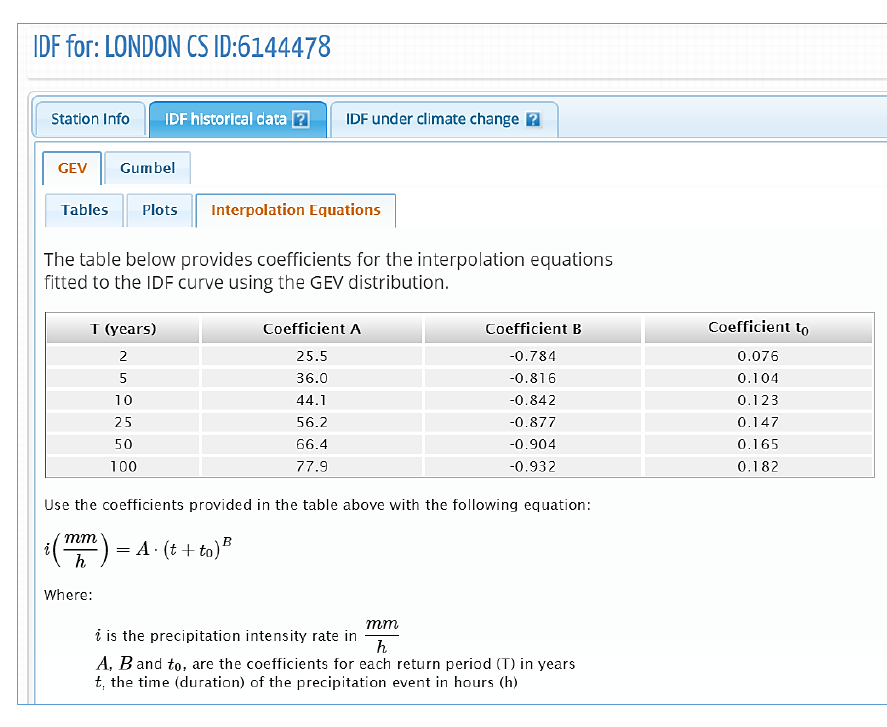
Figure 9. Total precipitation IDF depths.